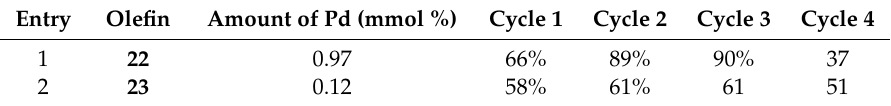
Table 6. Catalytic Heck reaction: yields over the different cycles.